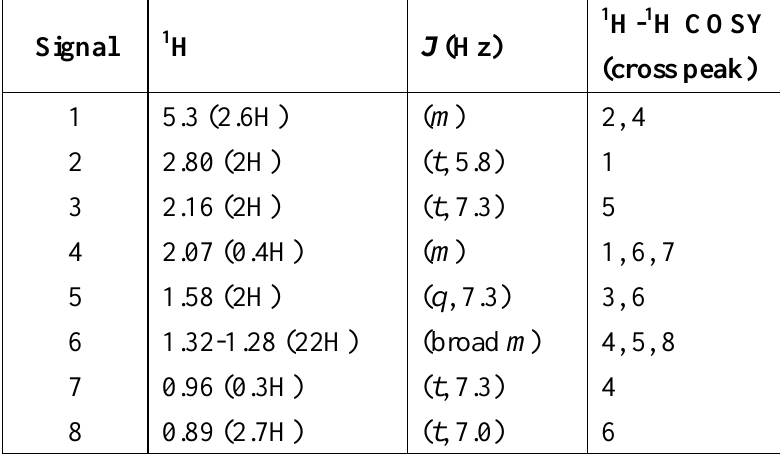
Table 1. 1 H-NMR spectroscopic data for 2-acyloxyethanephosphonate in CD